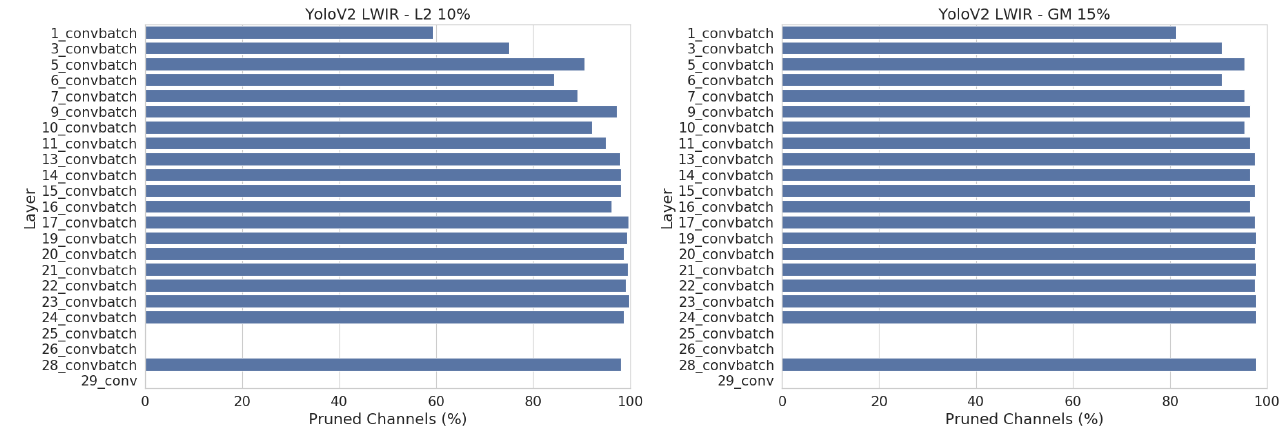
Figure 13. Number of pruned channels per layer after pruning YoloV2 on LWIR with L2 ( left ) and GM ( right ). The best pruned version of each are shown. Compared to Figure 9, the disadvantage of uniform pruning is less of an issue on this dataset, and thus GM pruning manages to outperform L2 pruning.